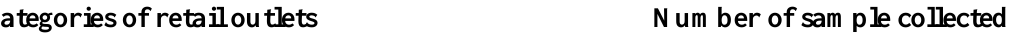
TABLE S1 : Number of samples collected per category of retail